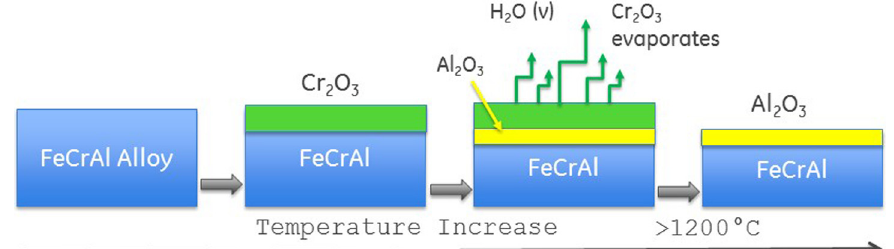
Fig. 3. Oxidation Behavior of FeCrAl in